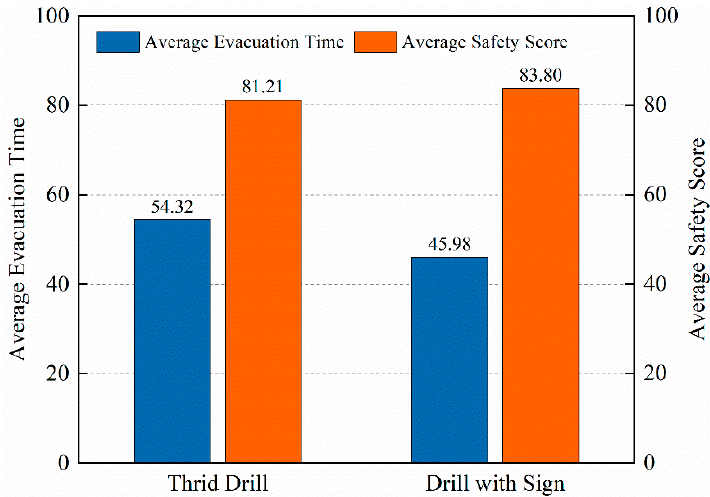
Figure 13. Average evacuation time and safety score of third drill and drill with sign.